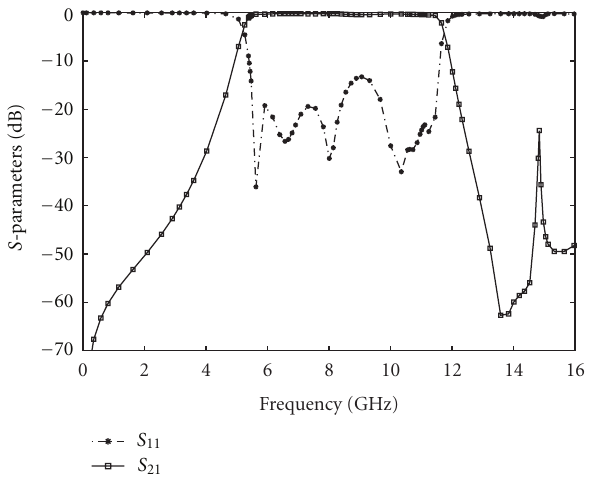
Figure 14: Scattering parameters for the bandpass resonator constructed by cascading three cells of DS-UC by MOM.